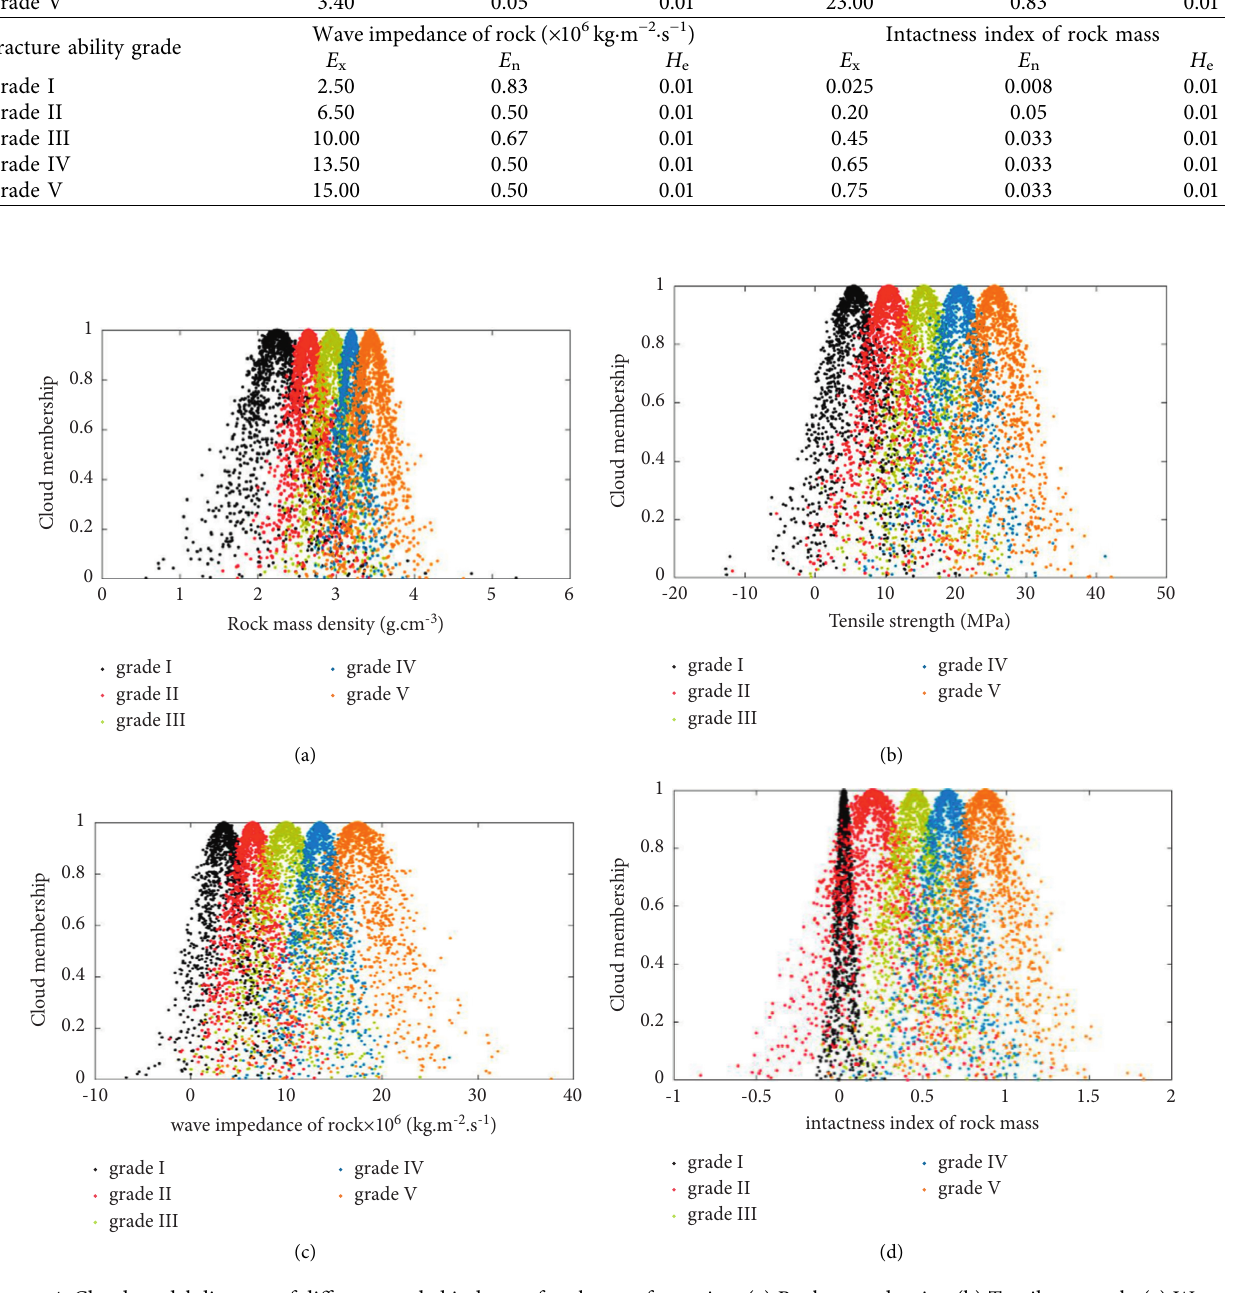
Figure 4: Cloud model diagram of different graded indexes of rock mass fracturing. (a) Rock mass density. (b) Tensile strength. (c) Wave impedance of rock. (d) Intactness index of rock mass.